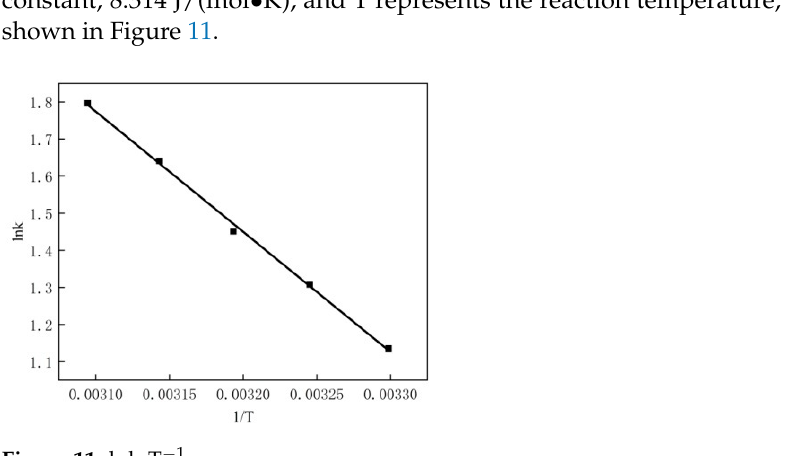
Figure 11. lnk-T − 1